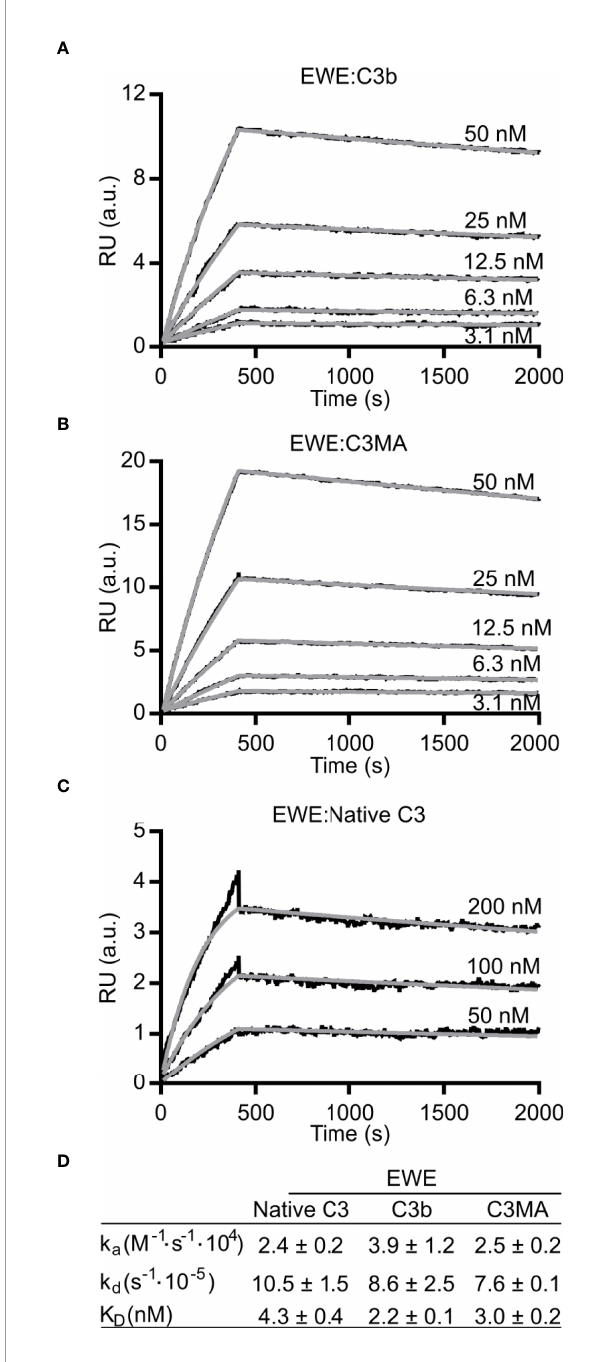
FIGURE 2 | Binding kinetics of EWE. Surface plasmon resonance based analyses of the interaction between EWE and (A) C3b, (B) C3MA, or (C) native C3. (D) Table summarizing the binding kinetics of EWE. The averages of rate constants for n=3 experiments are shown. The interaction with native C3 is possibly a result of C3 tick-over during the experiment. RU , response units. a.u. , arbitrary units. nM ,